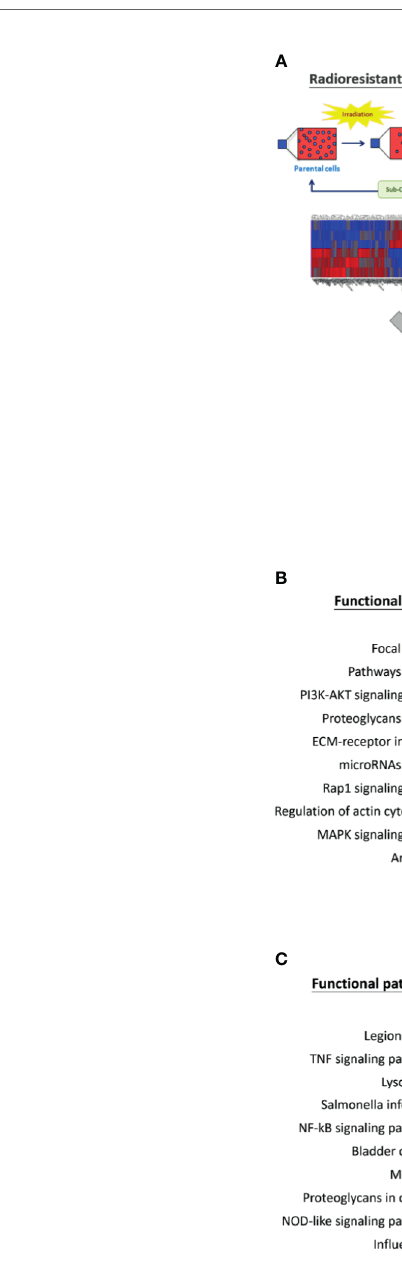
FIGURE 2 | Transcriptomic pro fi le and molecular pathways associated with cross-regulating function on cell invasion and radioresistance. (A) Conceptional design of the analytical strategy to investigate cross-regulatory genes for cell invasion and radioresistance. The pro fi les of differentially expressed genes (DEGs) were established after comparison of the transcriptomic datasets from three HNC cell lines (OECM1, Detroid, Fadu) and their sublines. (B) A list of the top 10 signi fi cant molecular pathways determined by DAVID enrichment analysis of the 349 up-regulatory genes. (C) A list of the top 10 signi fi cant molecular pathways determined by DAVID enrichment analysis of the 346 down-regulatory genes. Bar chart representing the classi fi cation of KEGG network. The enriched signi fi cance (p-value) values were negative base-2